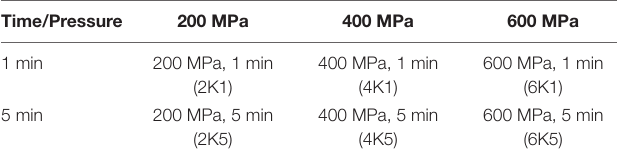
TABLE 1 | Pressure and time combinations for high pressure processing of cultivar Kimberley Large chickpea samples.